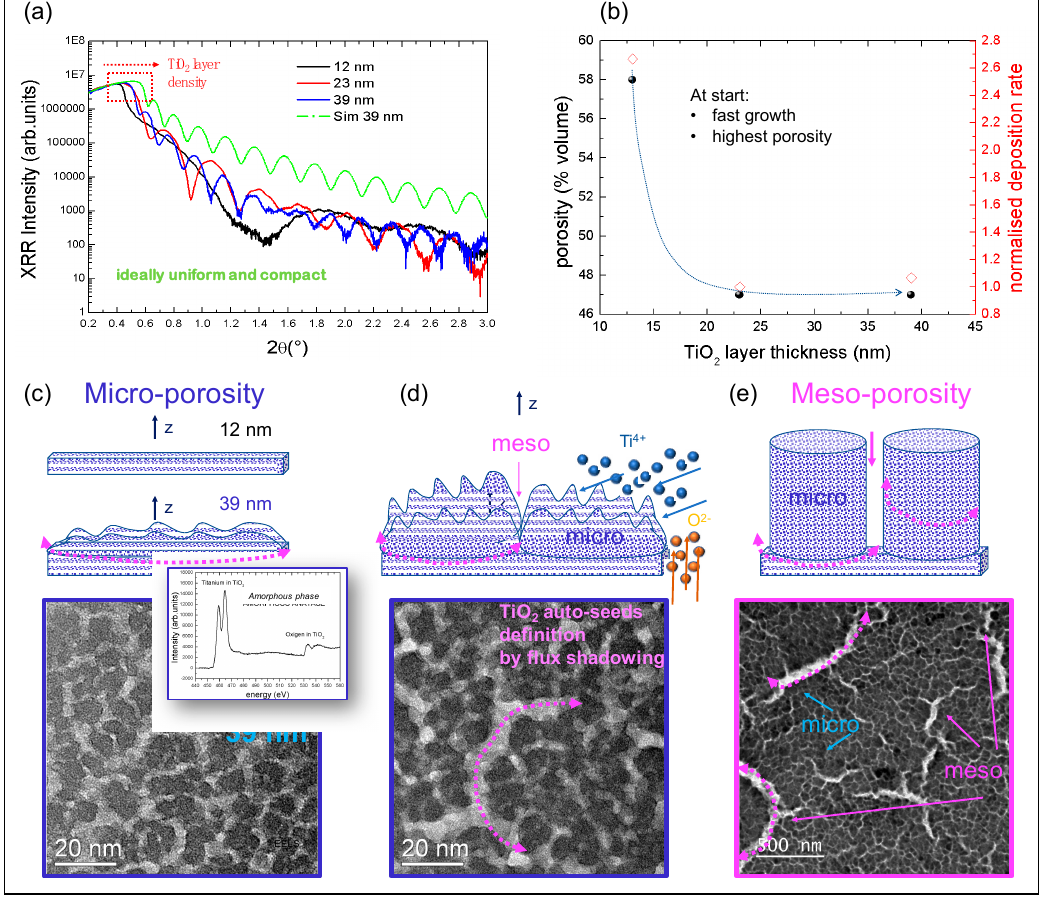
corresponds to the maximum porosity value; 2) a second regime in which porosity and deposition rate approach steady-state values of ~47% volume and ~4 nm/min, respectively. The presence of a first layer with high porosity (~12 nm-thick) was included for fitting the profiles of thicker layers. Above this porous basement, nanometric auto-seeds (10–20 nm in diameter, separated by gaps, namely micro-pores, initially of 2–10 nm in size) are statistically generated introducing a surface